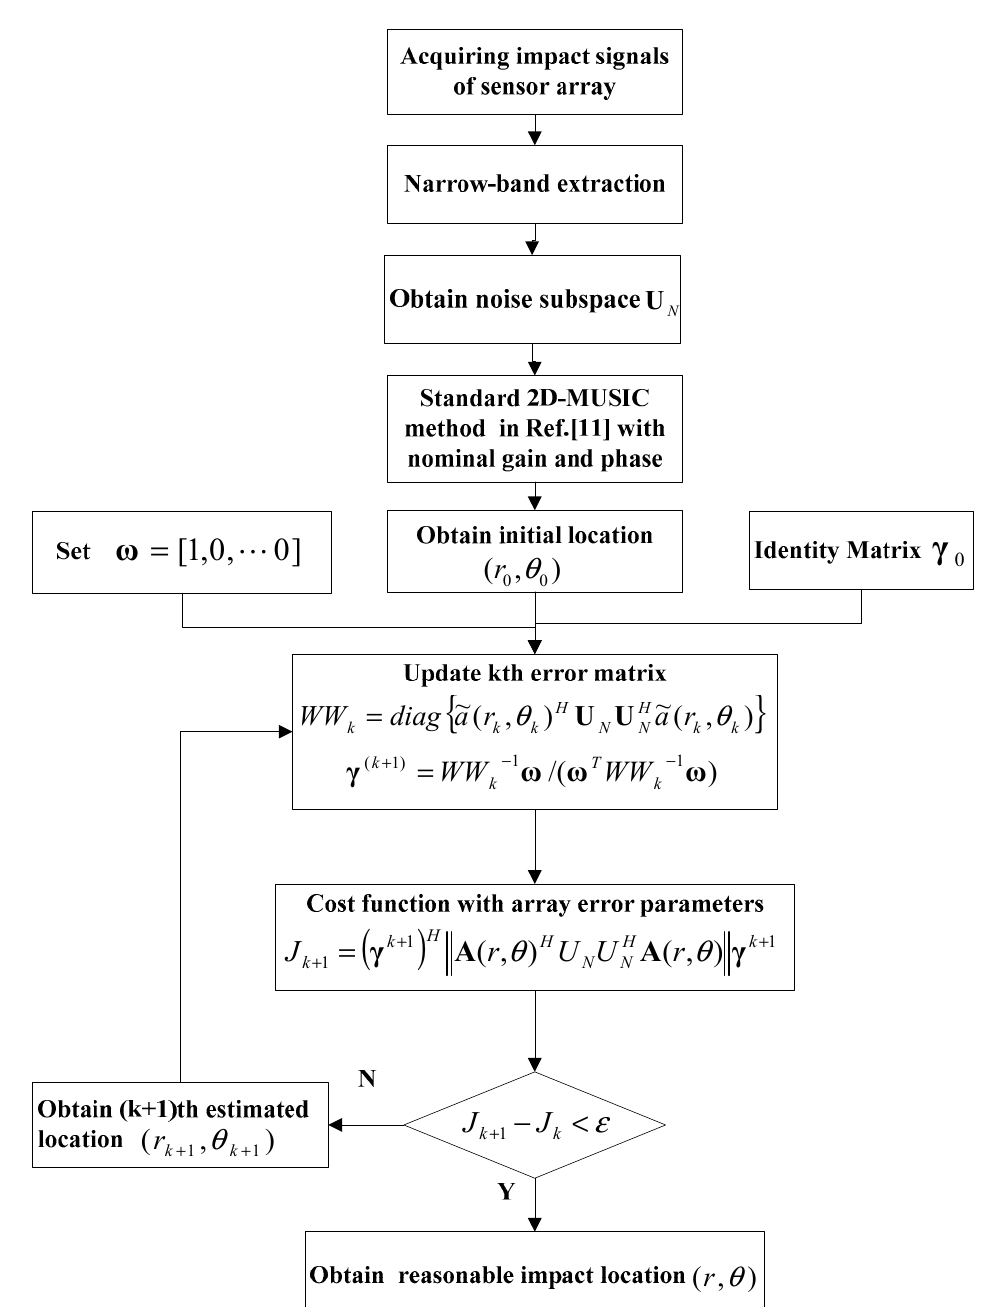
Figure2. Figure 2. Process of adaptive piezoelectric sensor array error calibration based on the 2D-MUSIC method.